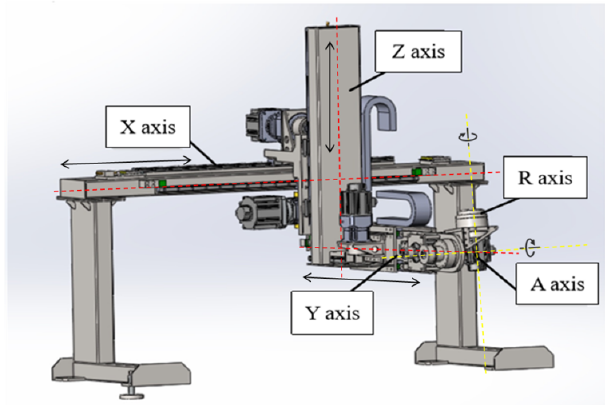
Figure 2. Coordinate system of 5 DOF Cartesian robot.